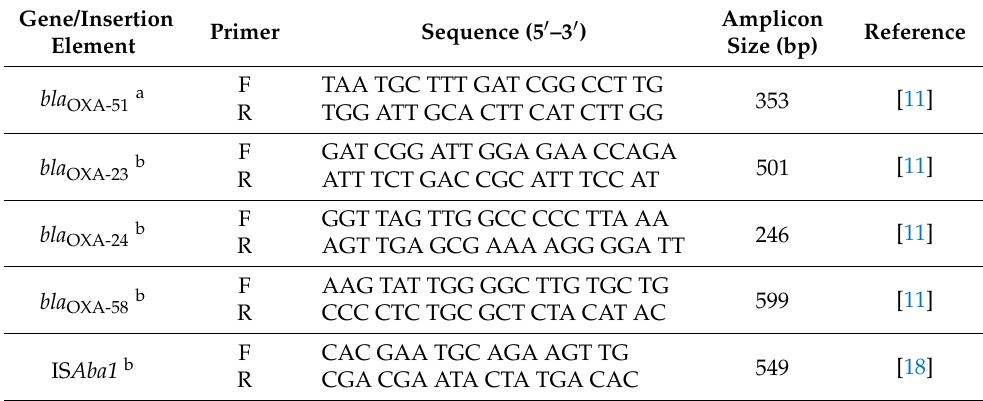
Table 1. The primer sequences used to detect the presence of four bla OXA genes and the insertion sequence IS Aba1